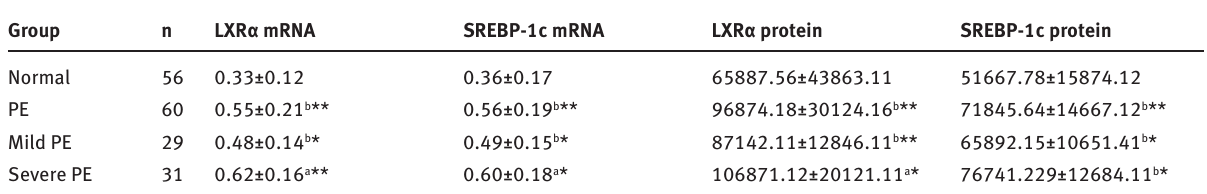
Table 2: The expression levels of LXRα and SREBP-1c in placentas of each group